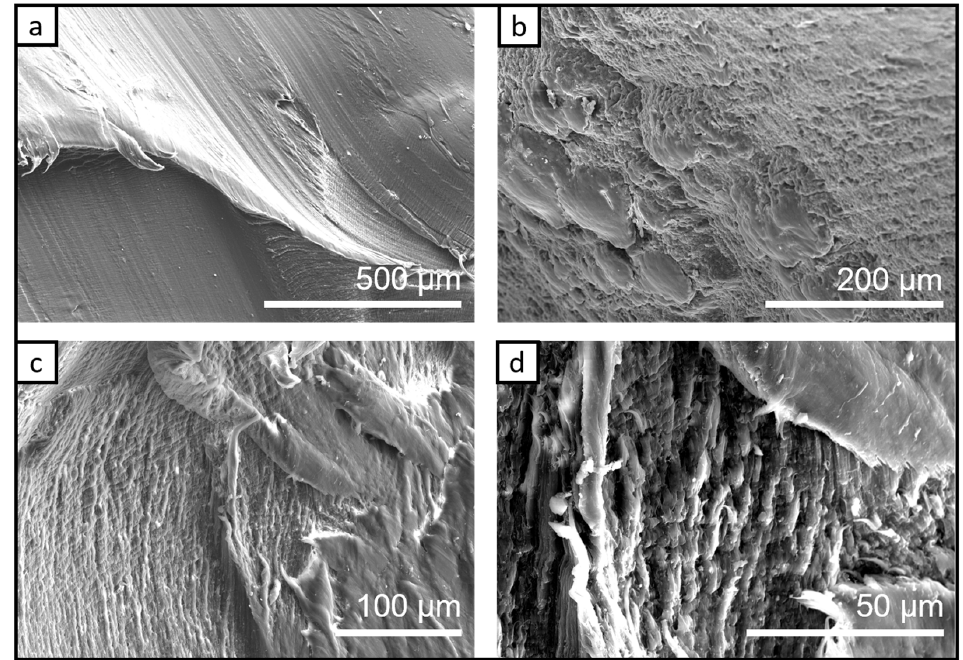
Figure 4. Representative SEM micrographs of bio ‐ PA1010 filled with 5% LDH nanocomposites after thermal treatment at 80 °C ( a ) and low magnification images showing the relatively smooth surface of the sample and detailed views of the small protuberances ( b – d ).